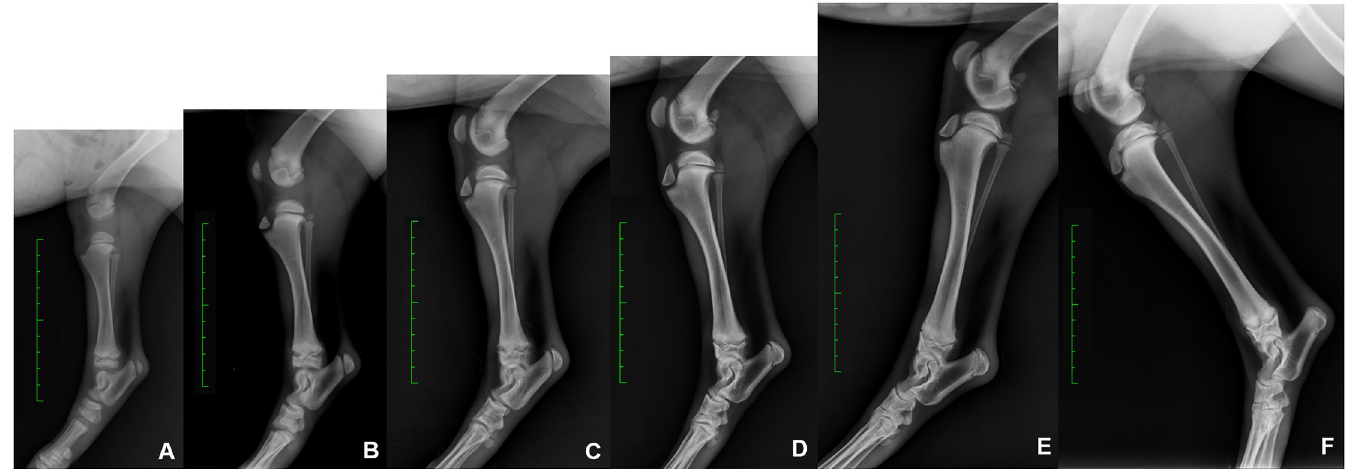
Fig 4. Representative series of radiographic images of the hindlimb skeletal development. Saarloos Wolfdog, medio-lateral view of the right hindlimb. A) 6 weeks of age; B) 8 weeks of age; C) 10 weeks of age; D) 12 weeks of age; E) 14 weeks of age; F) 16 weeks of age. Green scale bar: Distance between two hyphen is of 1 cm.